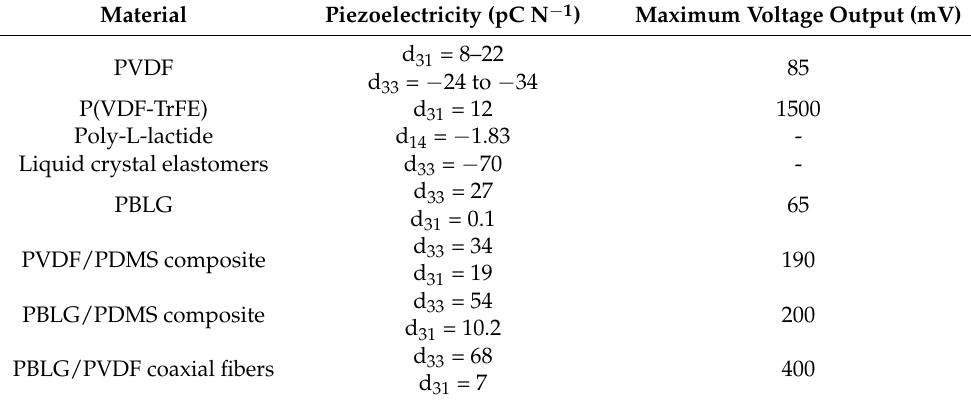
Table 2. Properties of several piezoelectric polymers and fiber-based composites